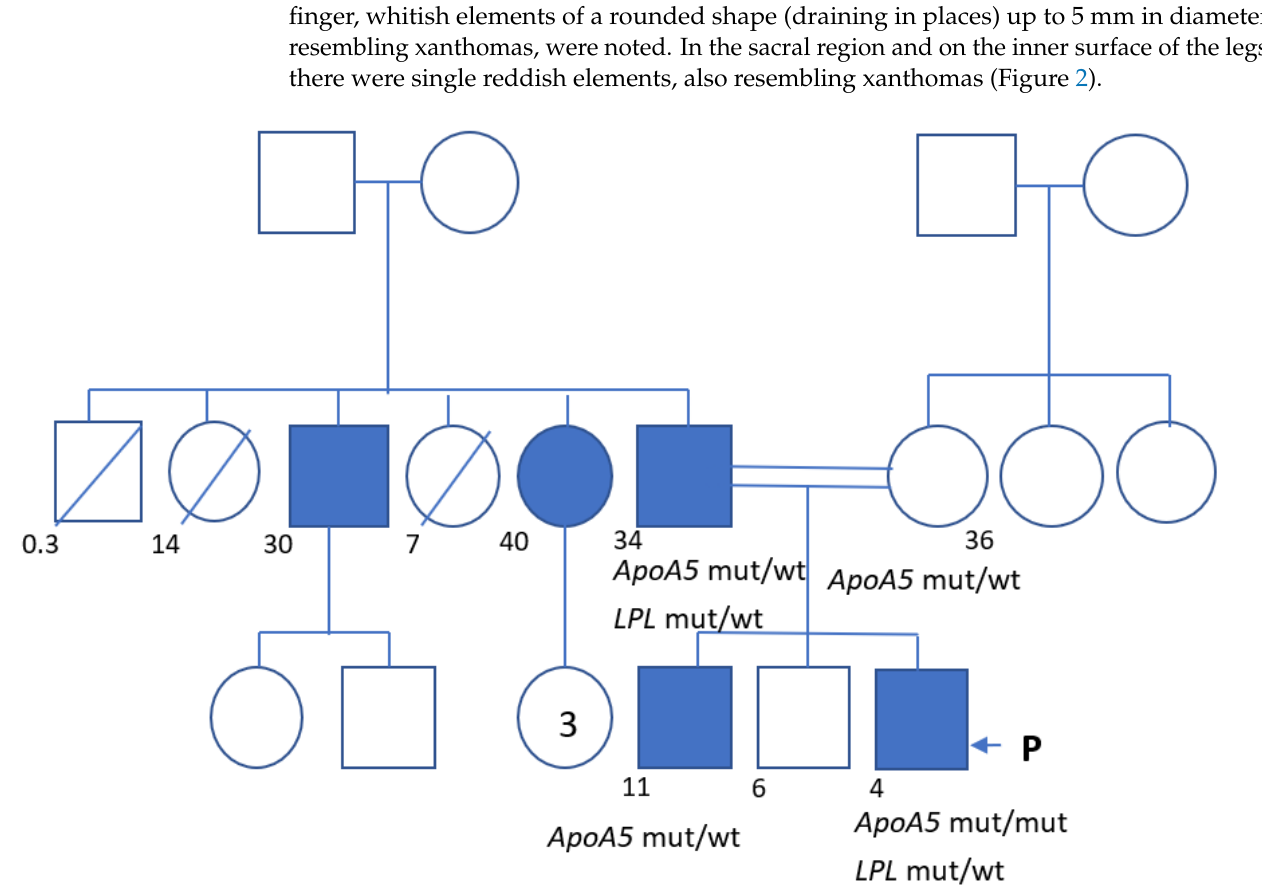
Figure 1. Pedigree of the family we are describing. P—proband. The numbers indicate the age at the time of the initial examination or the time of death.